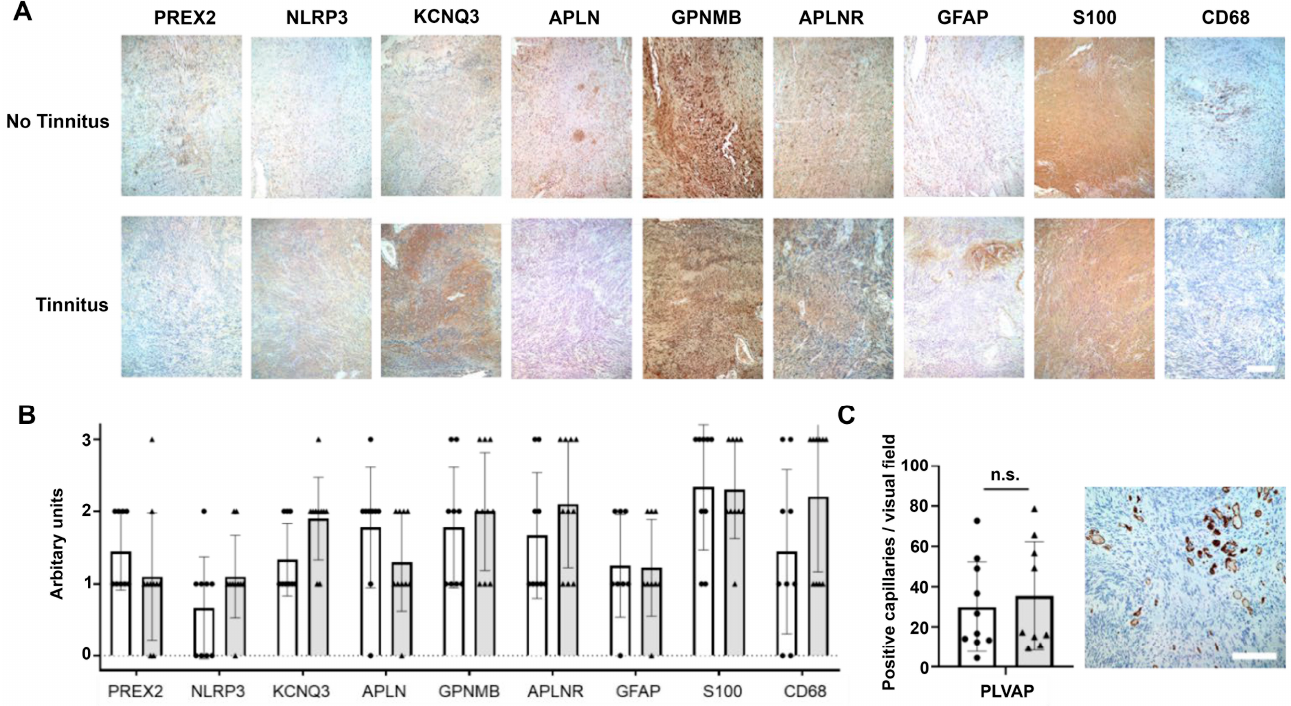
Figure 6. Validation of candidate genes identified via RNA-seq with immunohistochemistry. ( A ) Representative immunohistochemistry images of VS tissue from one patient without tinnitus (VS.N6) and one patient with tinnitus (VS.Y8). Tissue sections were immunostained for KCNQ3, NLRP3, PREX2, GFAP, GPNMB, APLNR, APLN, S100, and CD68. Scale bar = 200 µm. ( B ) Semi- quantitative measure of staining intensity in VS samples from patients with (gray bars, triangles) or without (white bars, circles) tinnitus. The scoring ranges from 1 (light to no staining) to 3 (strong positivity). There were no significant differences in staining intensity between the groups. ( C ) PLVAP staining of capillaries in VS tissue (example from VS-198). There was no significant differ- ence in PLVAP staining intensity or number of capillaries between the samples from patients with (gray bars and triangles) or without (white bars and circles) tinnitus. Error bars indicate the SD in panels B and C. Abbreviations: n.s., not significant; SD, standard deviation; VS, vestibular schwan- noma.